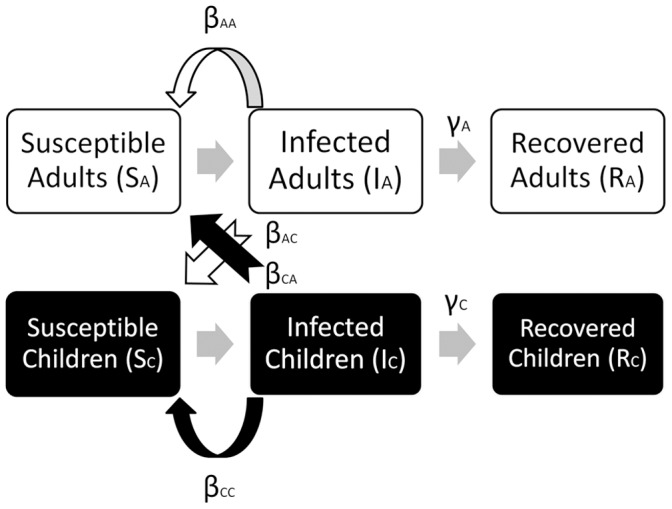
Flowchart illustrating the model.White boxes represent adults, while black boxes represent children. Light grey arrows indicate movements from one stage to another (susceptible to infected to recovered). White arrows represent infection of adults and children by contact with infected adults; likewise, black arrows represent a similar process with infected children.